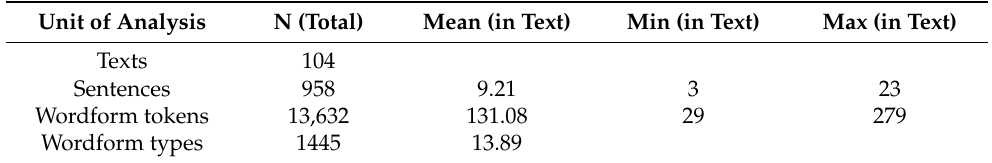
Table 1. Statistics for the text